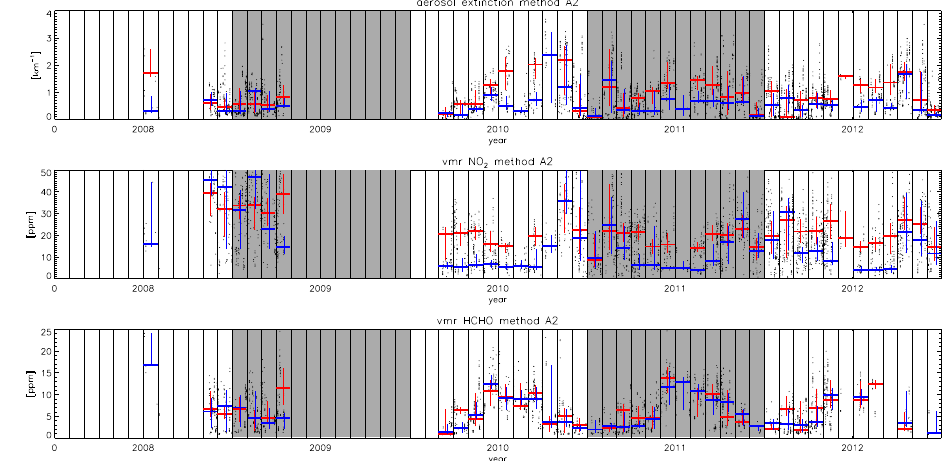
Figure 19. Time series of individual data points and monthly medians of near-surface aerosol extinction (upper row) and volume mixing ratios for NO 2 and HCHO (bottom row), retrieved with method A. Red refers to morning observations, blue to afternoon